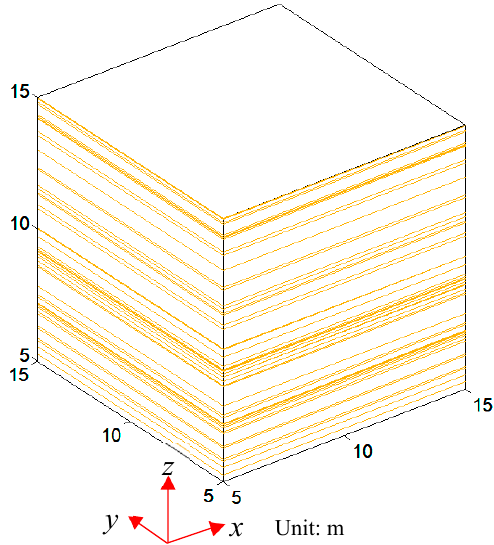
Figure 3. Three-dimensional bedding model of the Chang 7-2 shale reservoir.